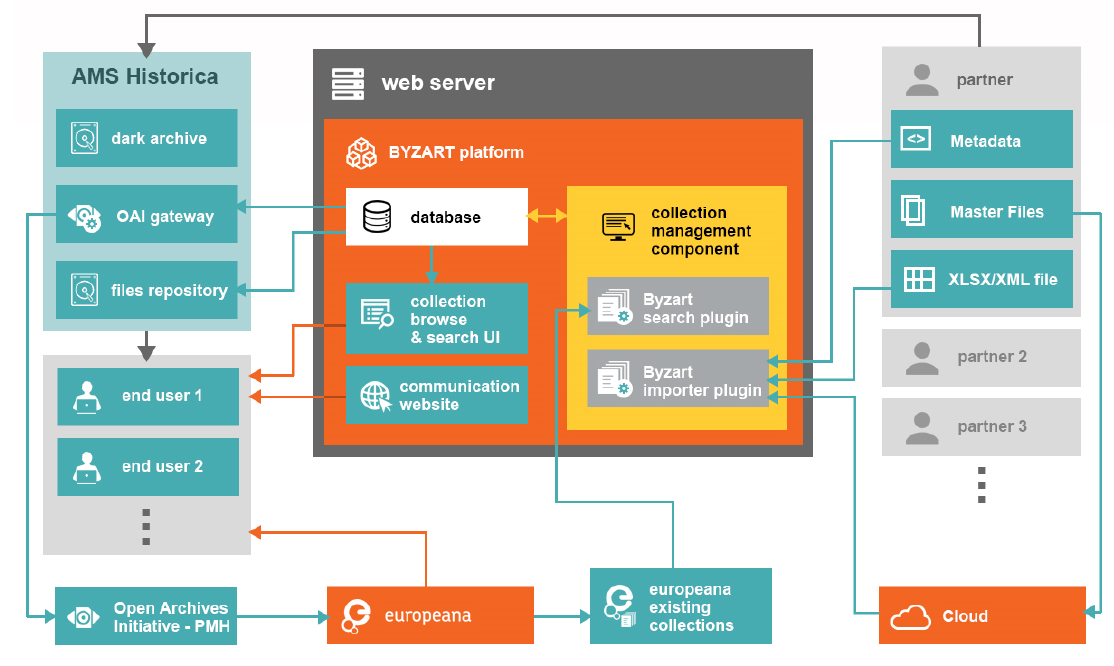
Figure 1. BYZART project data collection scheme.